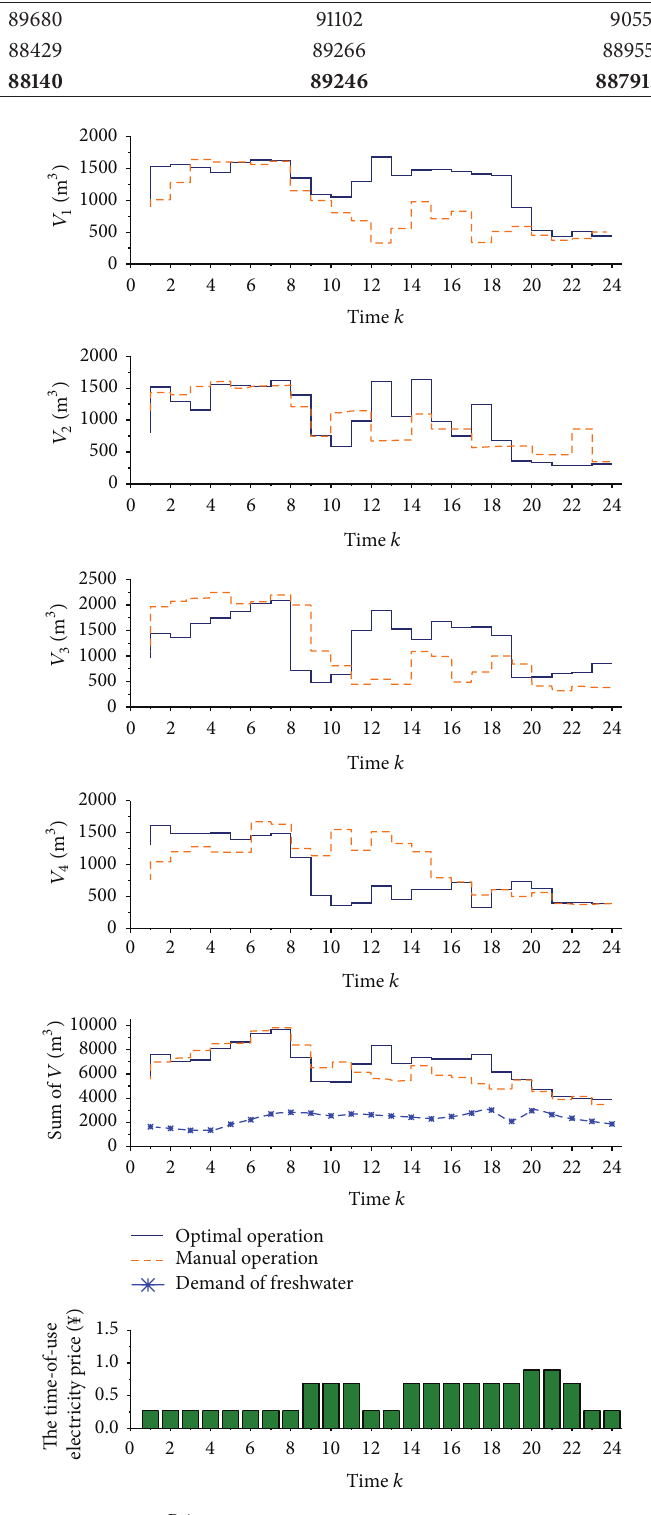
Figure 6: The comparison of capacity of each RO